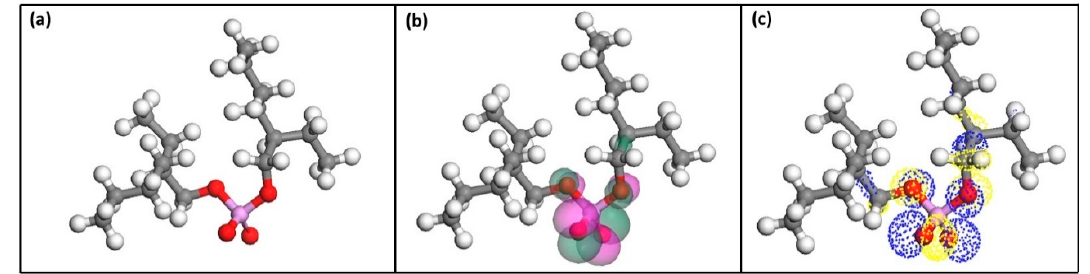
Figure 4. ( a ) Optimised structure of D2EHPA, ( b ) distribution of highest occupied molecular orbitals (HOMOs) of D2EHPA, and ( c ) distribution of lowest unoccupied molecular orbitals (LUMOs) of D2EHPA.